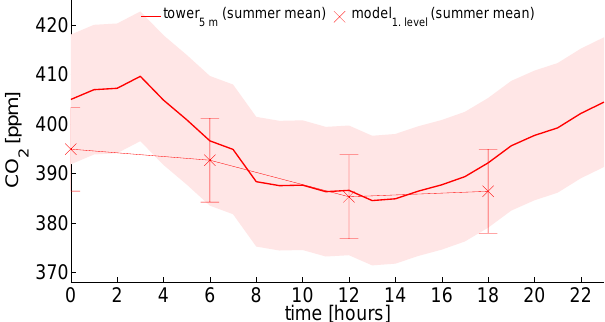
Fig. 10. Mean diurnal cycle for the summer. The red curve shows the mean diurnal cycle at the tall tower level of 5m (1 σ standard deviation shown shaded in red). The mean model outputs are given as red stars (1 σ standard deviation as error estimation). The model does not simulate the nocturnal CO 2 accumulation in the